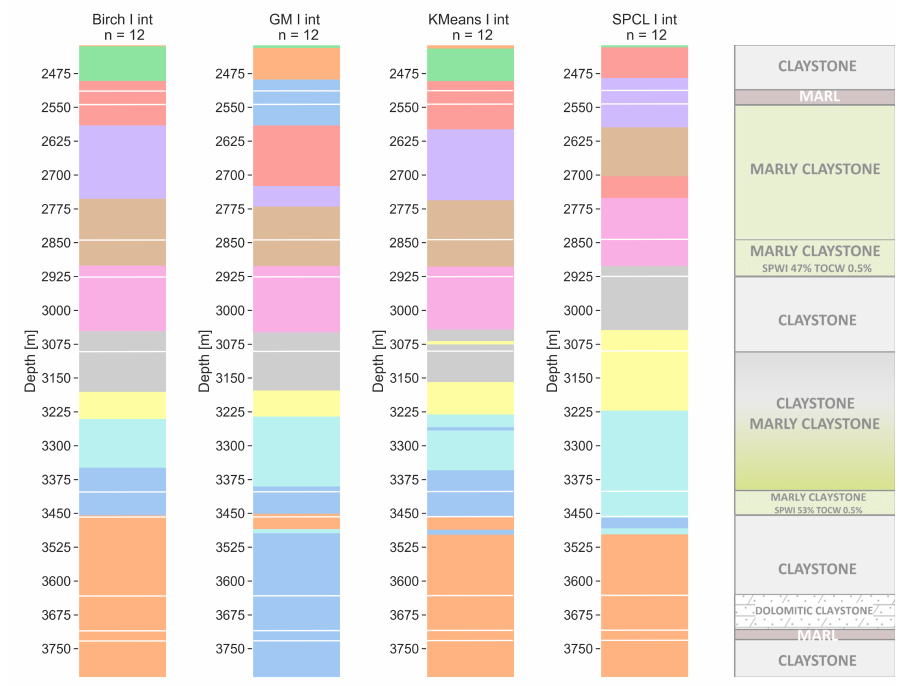
Figure 11. Sonic tool resolution clustering models for a number of clusters equal to 12 with lithology from well core (with lines). Clustering methods: BIRCH—balanced iterative reducing and clustering using hierarchies, GM—Gaussian mixture model, k-means, and SPCL—spectral